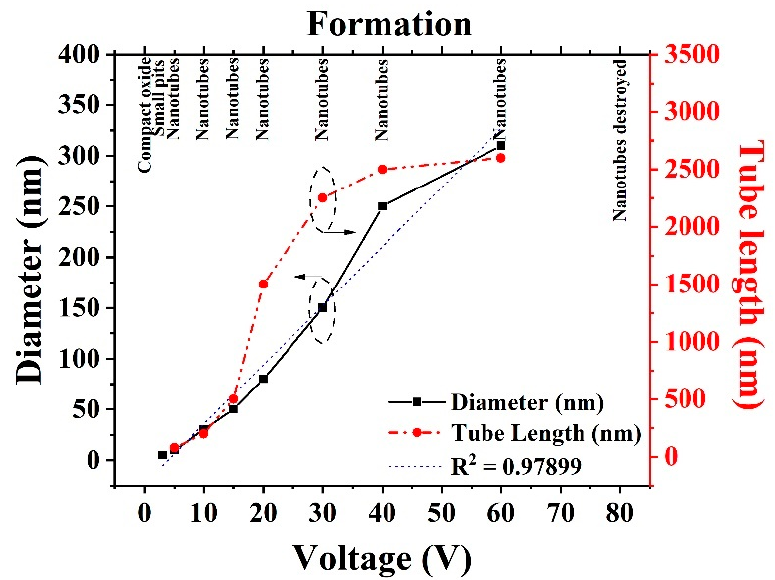
Figure 4. Anodic film formation features (NH 4 F = 0.5 wt.%, time = 90 min) at 1, 3, 5, 10, 15, 20, 30, 40, 60, and 80 V in a water–glycerol